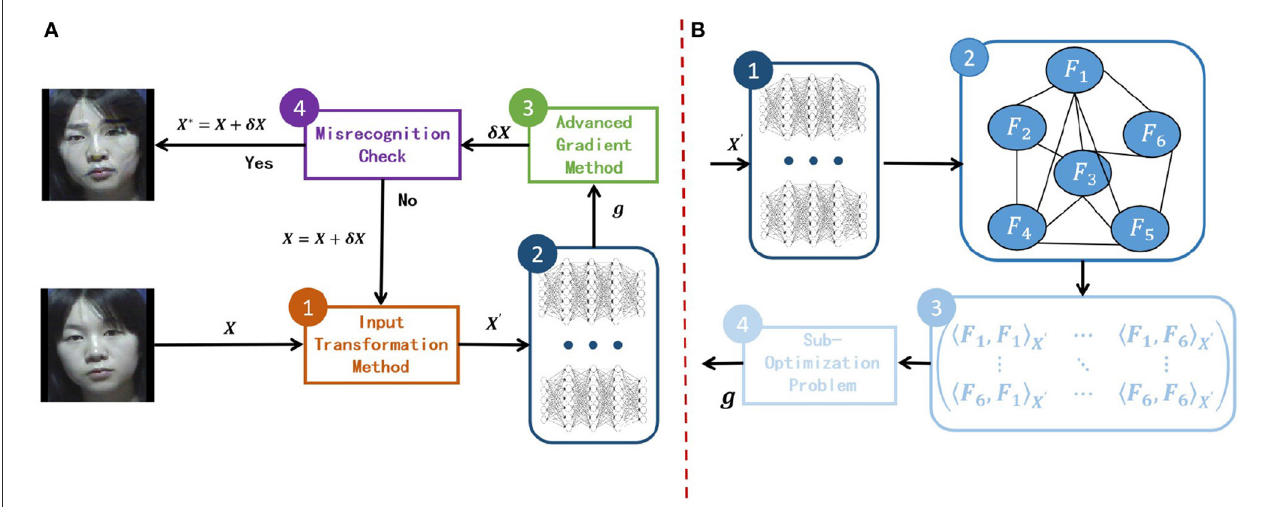
FIGURE1 (A) An attack framework that combines multi-model ensemble attacks with existing attack methods which are advanced gradient optimization techniques and input transformation techniques. (B) The overall RGEA calculation process, where the set of surrogate models is